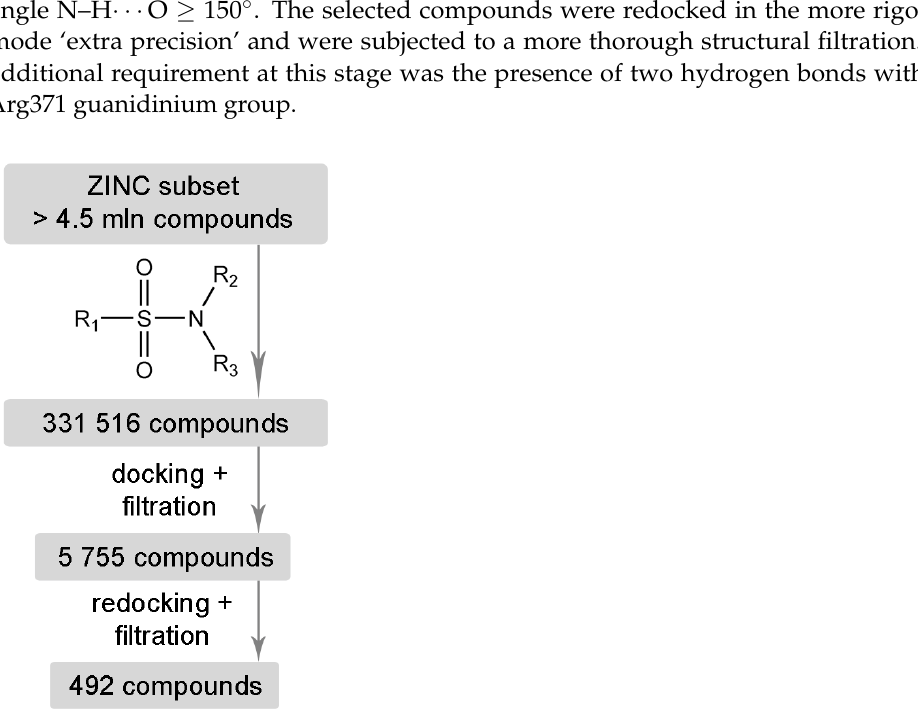
tance between guanidinium nitrogen and sulfonamide oxygen ≤ 3.1 Å, the corresponding